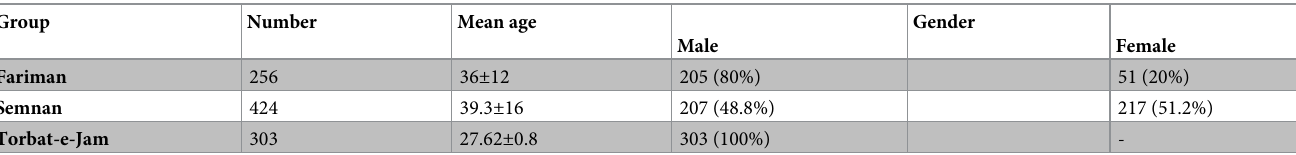
Table 1. Age-based distribution of